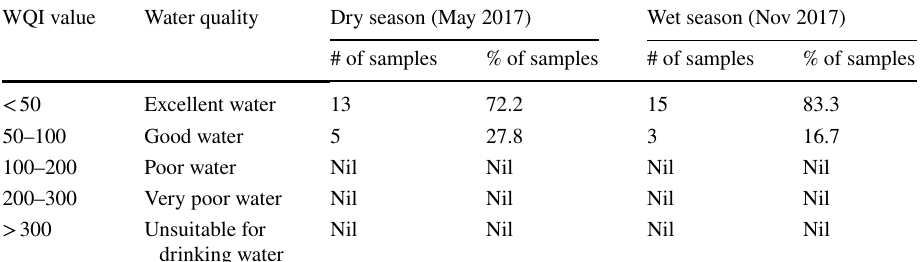
Fig. 3 The proportion of groundwater samples in the study area classified based on WQI: a dry season, b wet